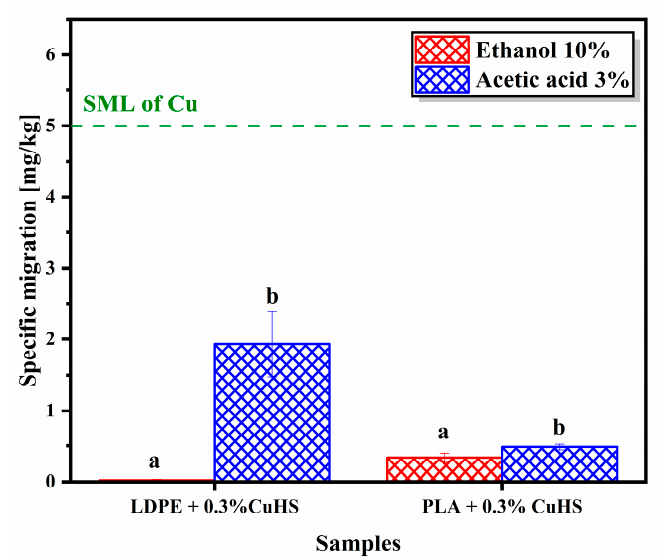
Figure 5. Specific migration of copper from the LDPE and PLA samples with 0.3% CuHS in the food simulants ethanol (10% v / v ) and acetic acid (3% v / v ). The SML takes into account the standard value of 5 mg/kg of Cu for a 6 dm 2 /kg sample testing, according to the Regulation 10/2011 [34]. The error bars show the standard deviation of the five independent samples tested. Similar letters/symbols mean no statistical significance, while different letters/symbols mean statistical significance.